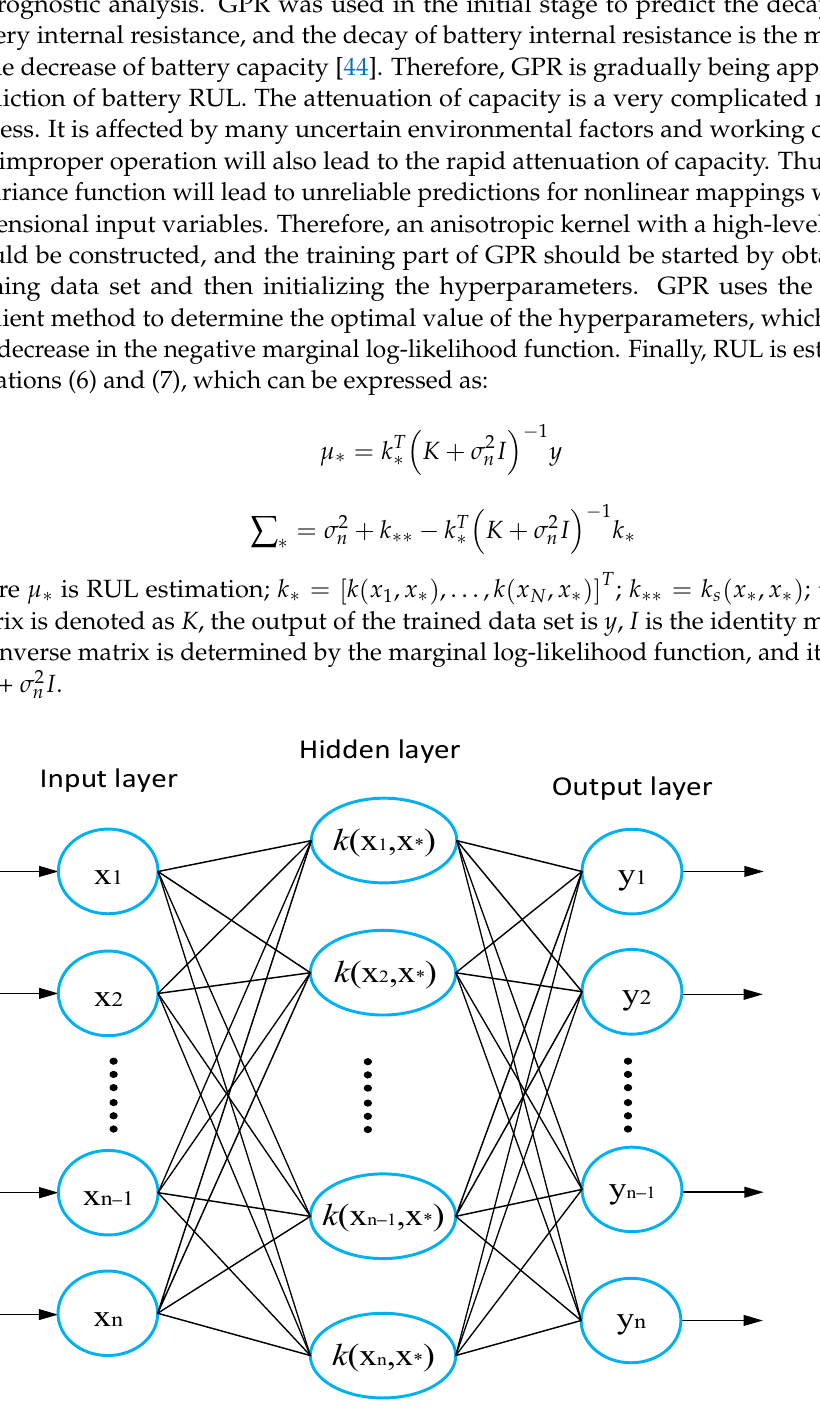
Figure 3. Gaussian process regression algorithm structure diagram.